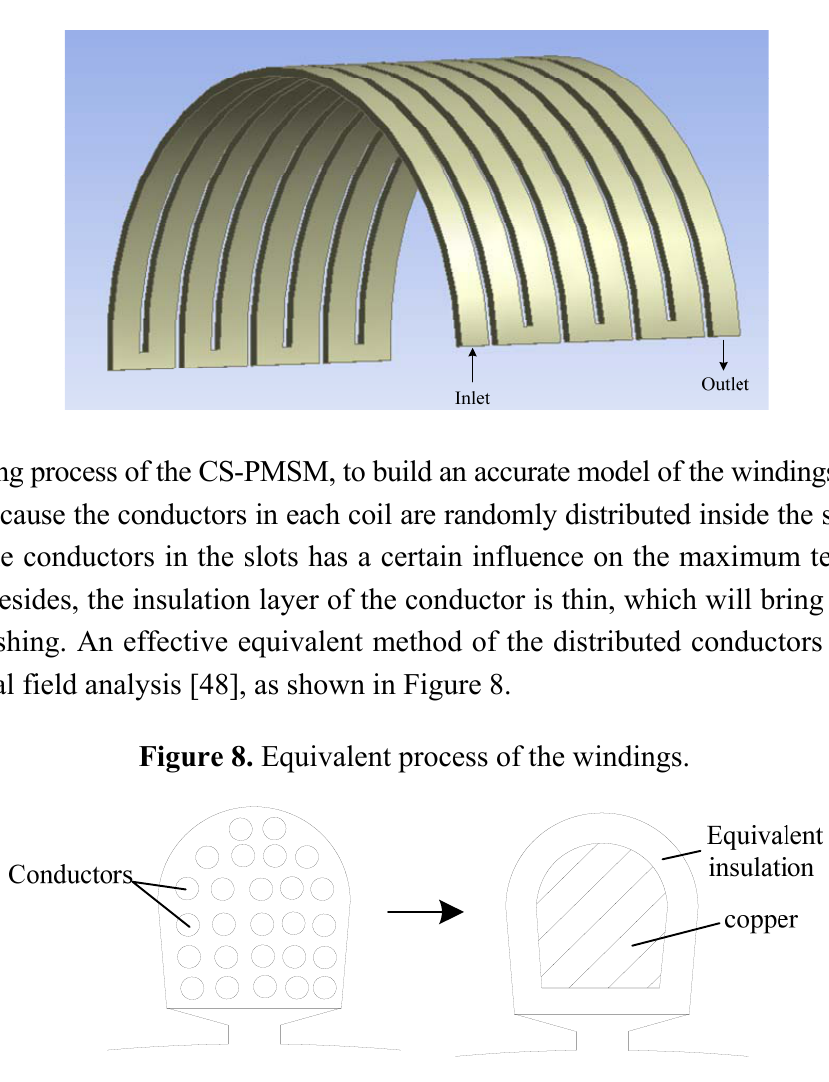
Figure 7. 3-D FEA model of the cooling water channel.